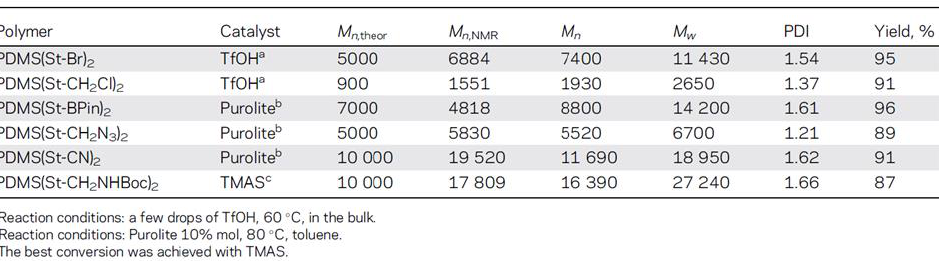
Figure 18. Reaction Conditions and Molecular-Weight Characteristics of Synthesized Telechelic Bi- functional PDMS (adapted with permission from Ref. [107]. 2018, Drozdov, F.)